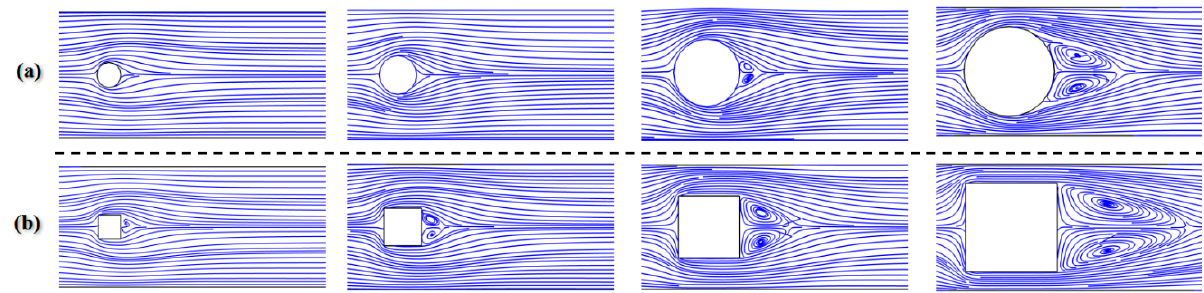
Figure 19. The mixing indices of cylindrical obstacle and square obstacle under different Ω values.